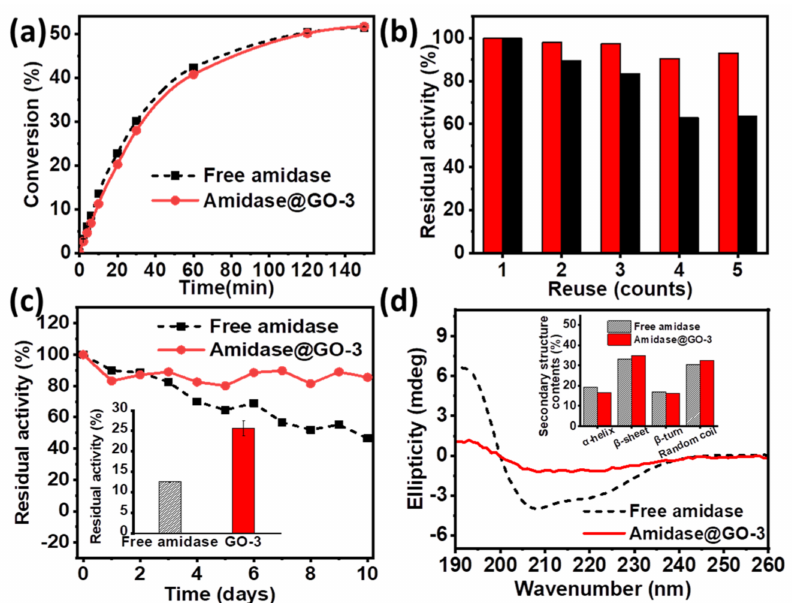
Figure 4. ( a ) Conversion plots of the production of L-4-fluorophenylglycine catalysed by free amidase and amidase@GO-3; ( b ) reuse of immobilized amidase on GO (black column) and GO-3 (red column); ( c ) Storage stability and high temperature tolerance (inset) of free and amidase@GO-3; ( d ) CD spectra and secondary structure contents (inset) of free amidase and amidase@GO-3.